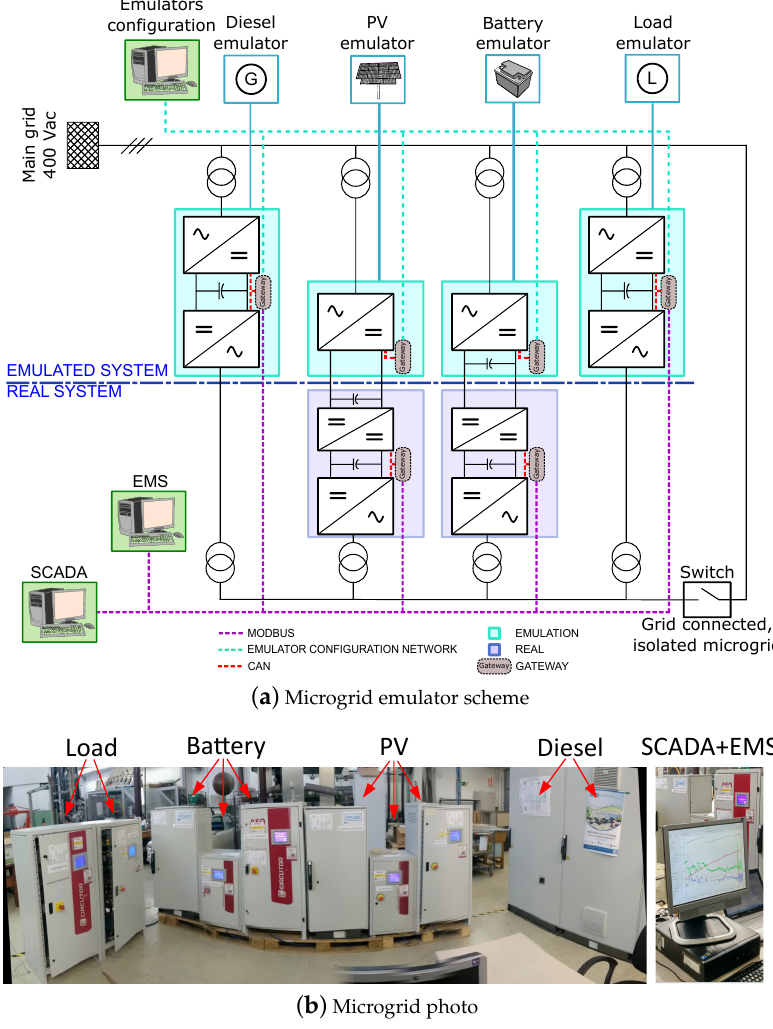
Figure 9. Microgrid